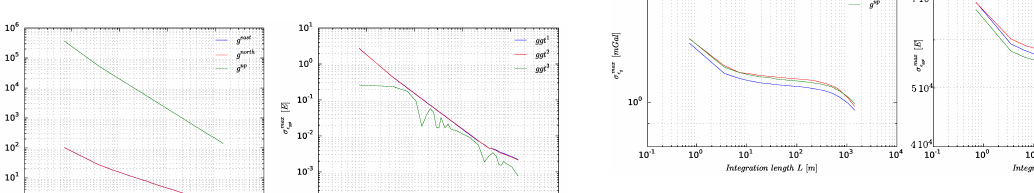
Figure 11: Effect of the accelerometer measurements